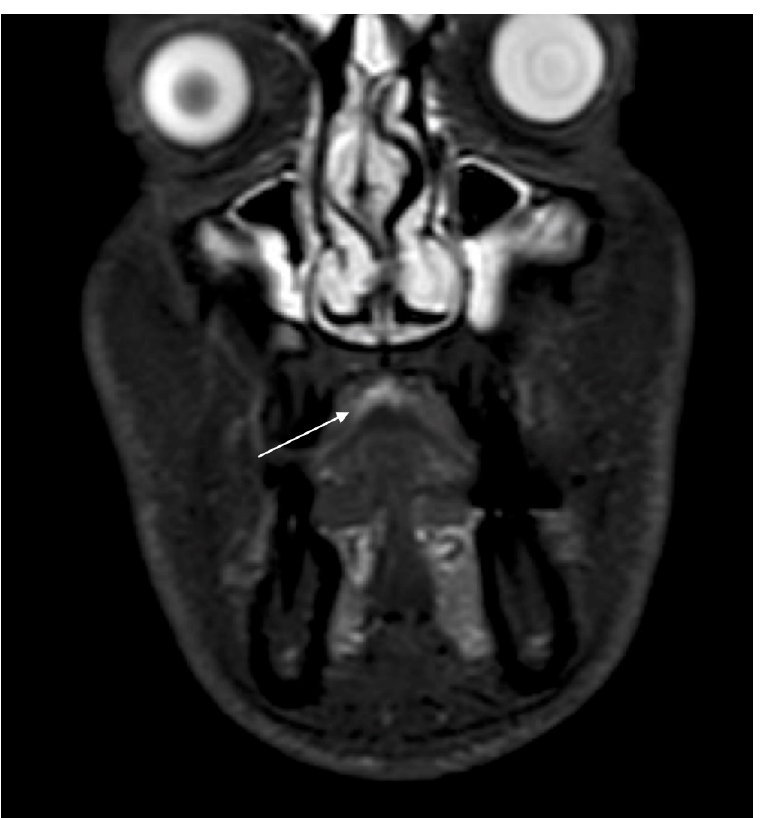
Figure 3. Maxilla–facial MRI in T1WI revealed, in the central area of the hard palate, a thickening of the mucosa of 3–4 mm, with no apparent bone infiltration.